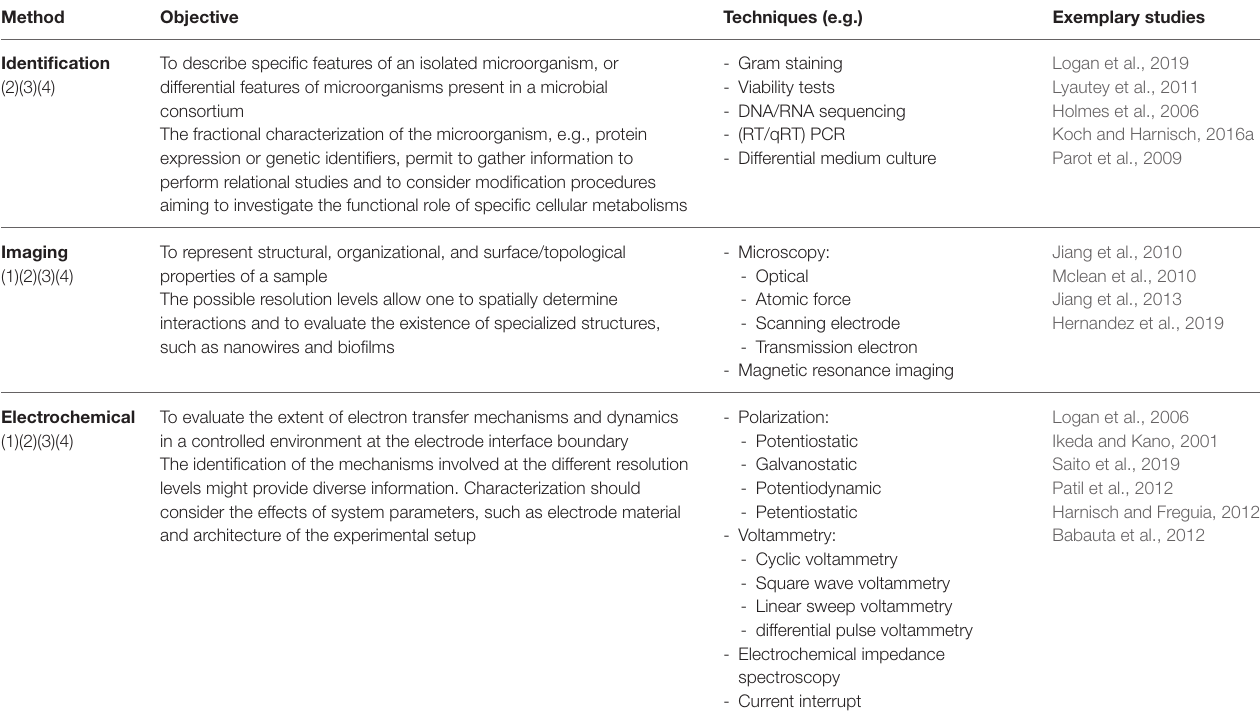
TABLE 1 | Level-transversal techniques for the characterization of